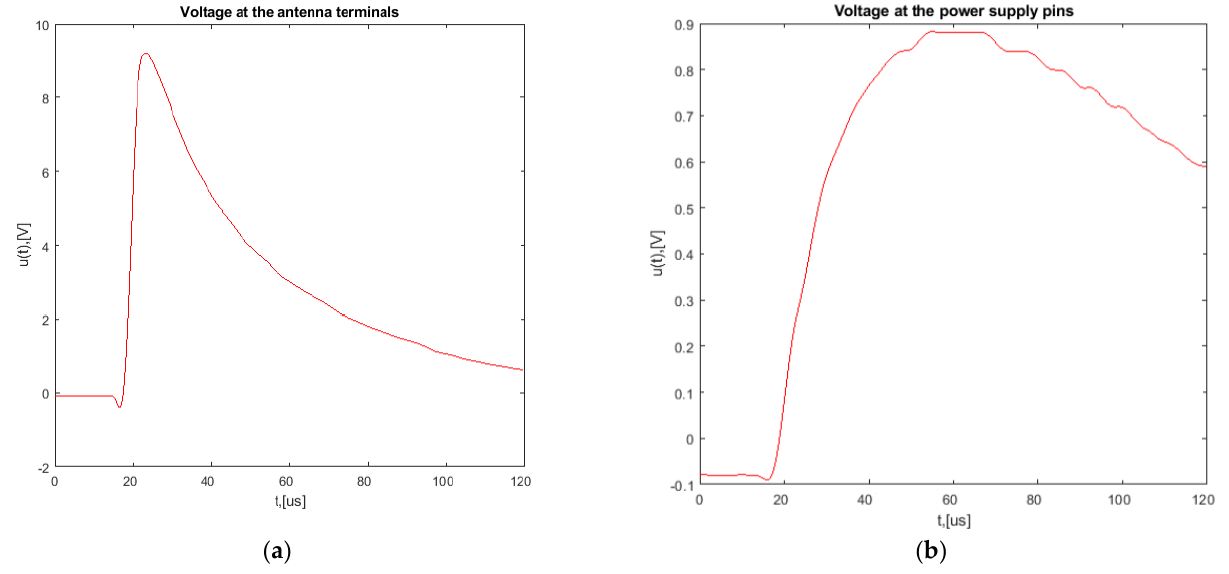
Figure 10. ( a ) Input—Voltage measured at the antenna terminals; ( b ) Output—Voltage measured at the power supply terminals.